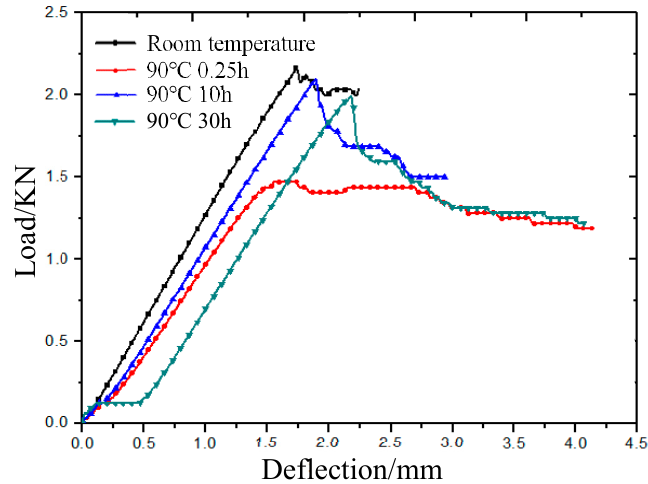
Figure 2. Bending deflection–load curve of 3Dim–5Dir braided composites at 90 °C with different durations.